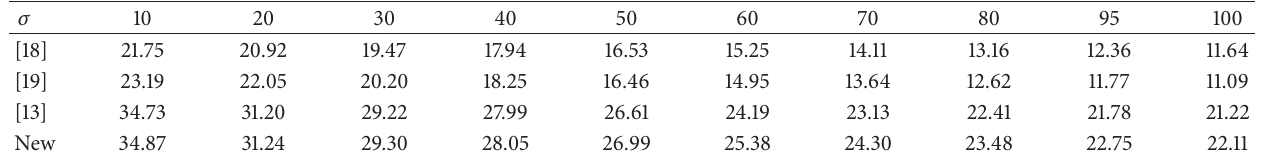
Table 4: PSNR of different algorithms with different Gaussian noise levels for Tennis video sequence.